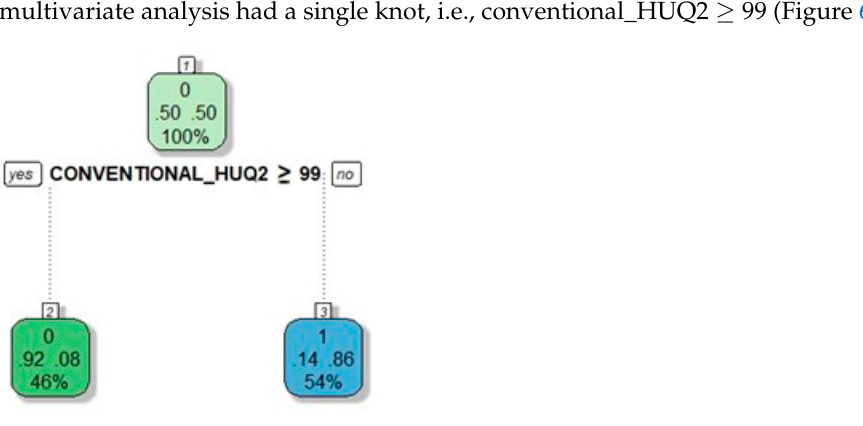
Figure 6. Decision tree for the prediction of NASH (based on model in Table 5). Nodes correspond to the decision steps. Each colored square reports: (a) the response mode class in the node, i.e., the predicted outcome of that node (presence of NASH =1; absence of NASH =0, the top number in the square); (b) the percentages of observations in the node belonging to the first response class (absence of NASH) and the second response class (presence of NASH) (the two central numbers in the square, summing up to 1); (c) the percentage of the total population falling into the node (the bottom number in the square). Decision rules are specified on each node.